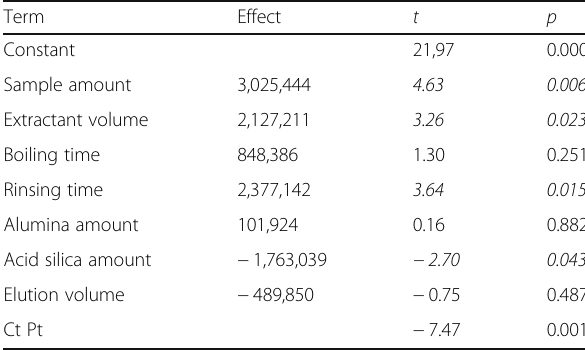
Table 3 Value of estimated effects of experimental parameters for SCCP